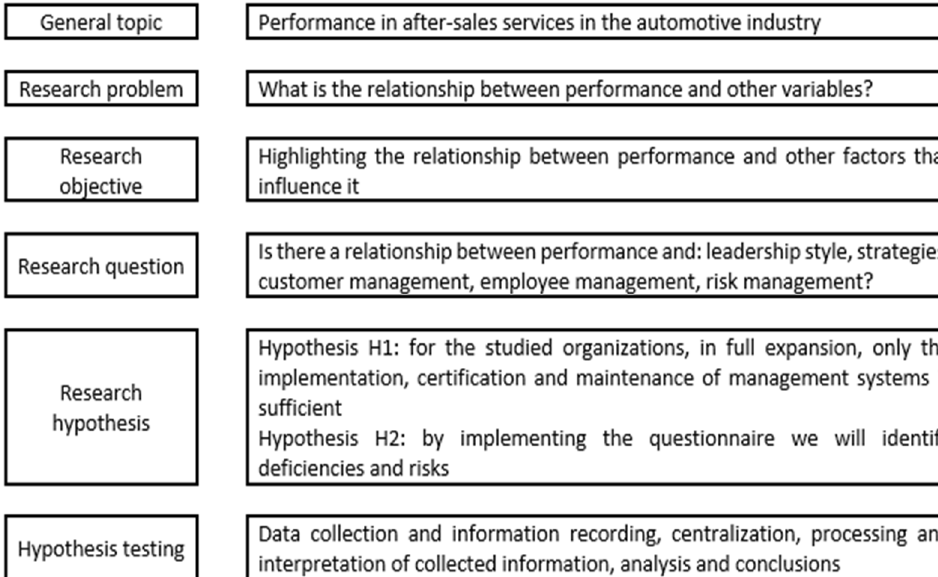
Figure 1. Concrete steps in the elaboration of the study (developed by the author).